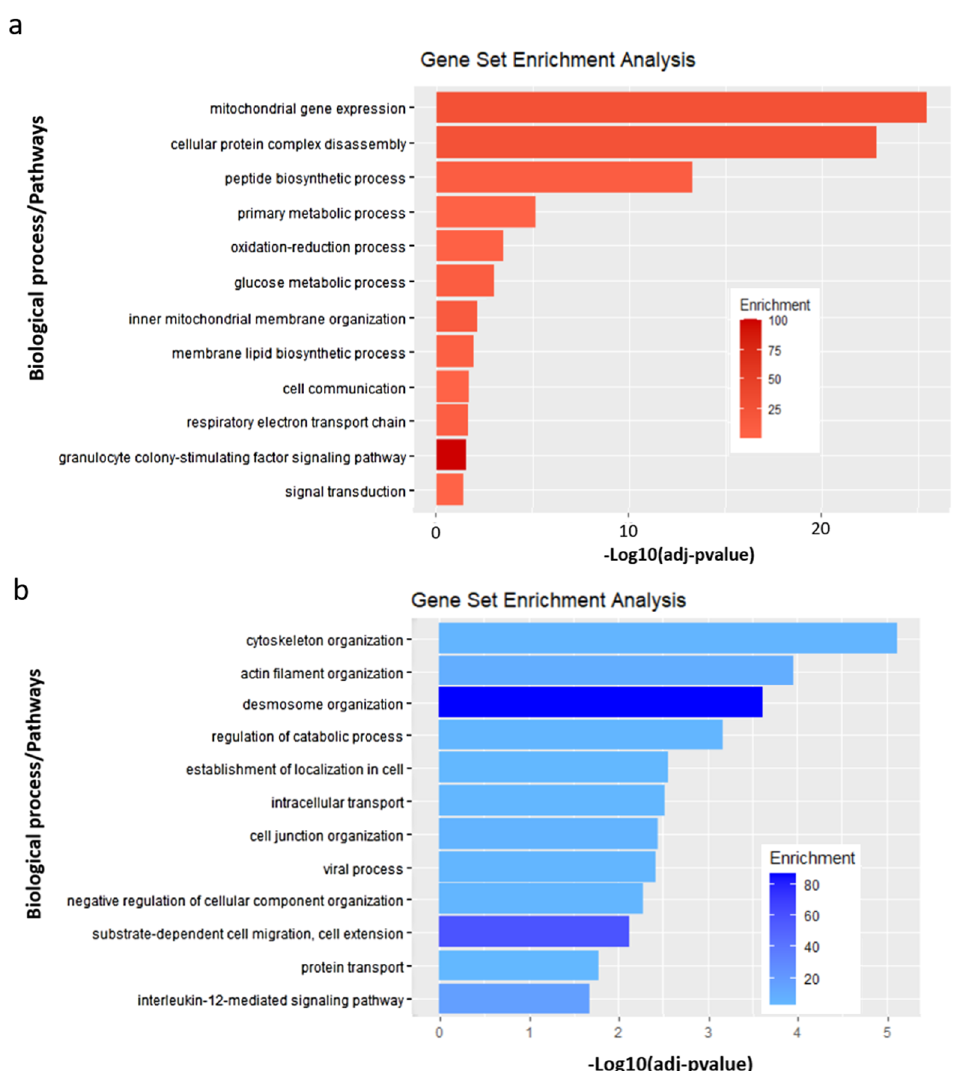
Figure 5. Enriched pathways in HIBCPP cells following E-30 infection versus uninfected control. ( a ) Top 12 significantly up-regulated pathways in HIBCPP cells infected with E-30 compared to uninfected control. Analysis was performed using Gene Ontology enrichment tool (GOTE). The shade of red is representative of the grade of pathway enrichment. ( b ) Top 12 significantly down-regulated pathways in E-30 infected HIBCPP cells compared to uninfected control. The shade of blue is representative of the grade of enrichment. Data are shown for 3 independent experiments. Analysis was performed using Gene Ontology enrichment tool and resulted in a binomial statistic p -value and pathway fold enrichment (calculated as suggested by [31]).